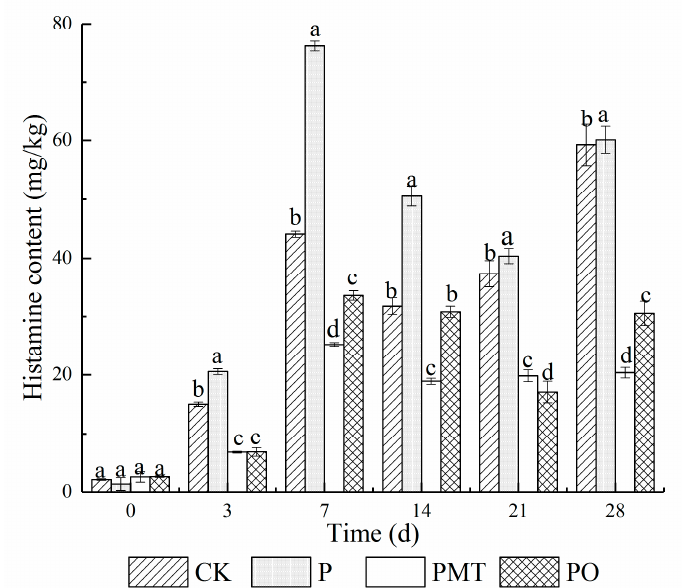
Figure 3. Effect of thyme microcapsules on histamine accumulation in smoked horsemeat sausage during fermentation and ripening (average ± standard deviation, n = 3). (a–d): Values in the same column and batch not followed by a common letter are significantly different ( p < 0.05) between days. Batch CK: the spontaneously fermented as the control; batch P: inoculated with P. bacillus ; batch PMT: inoculated with P. bacillus and thyme microcapsules; batch PO: inoculated with P. ba- cillus and essential oil.